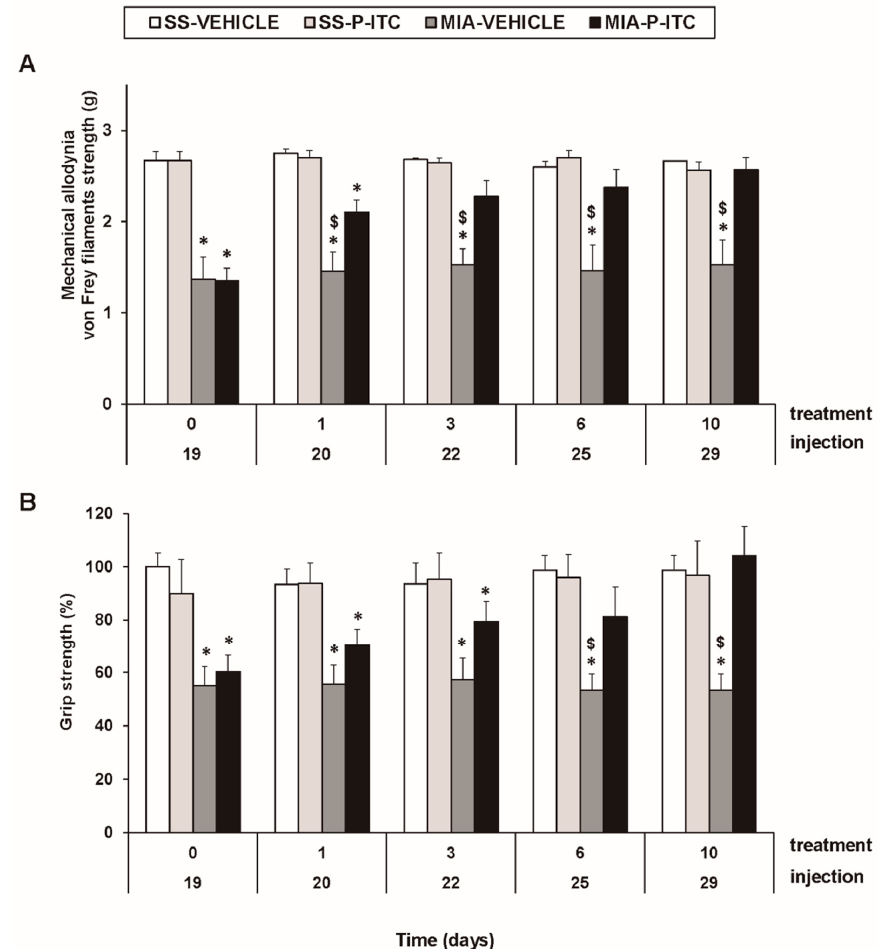
Figure 2. Treatment with phenyl isothiocyanate (P-ITC) decreases the mechanical allodynia and the grip strength deficits induced by the intra-articular injection of MIA. The development of ( A ) the